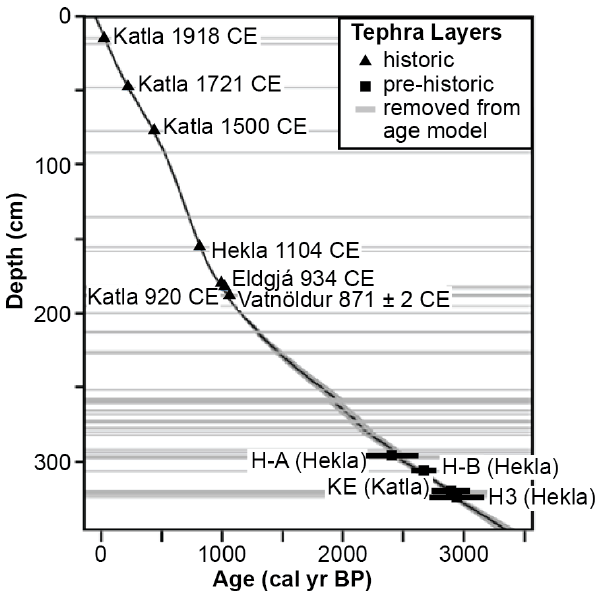
Figure 2. Age model for Vestra Gíslholtsvatn with historic and pre- historic tephra layers (previously identified by Blair et al., 2015 and Christensen, 2013) indicated (figure adapted from Richter et al.,